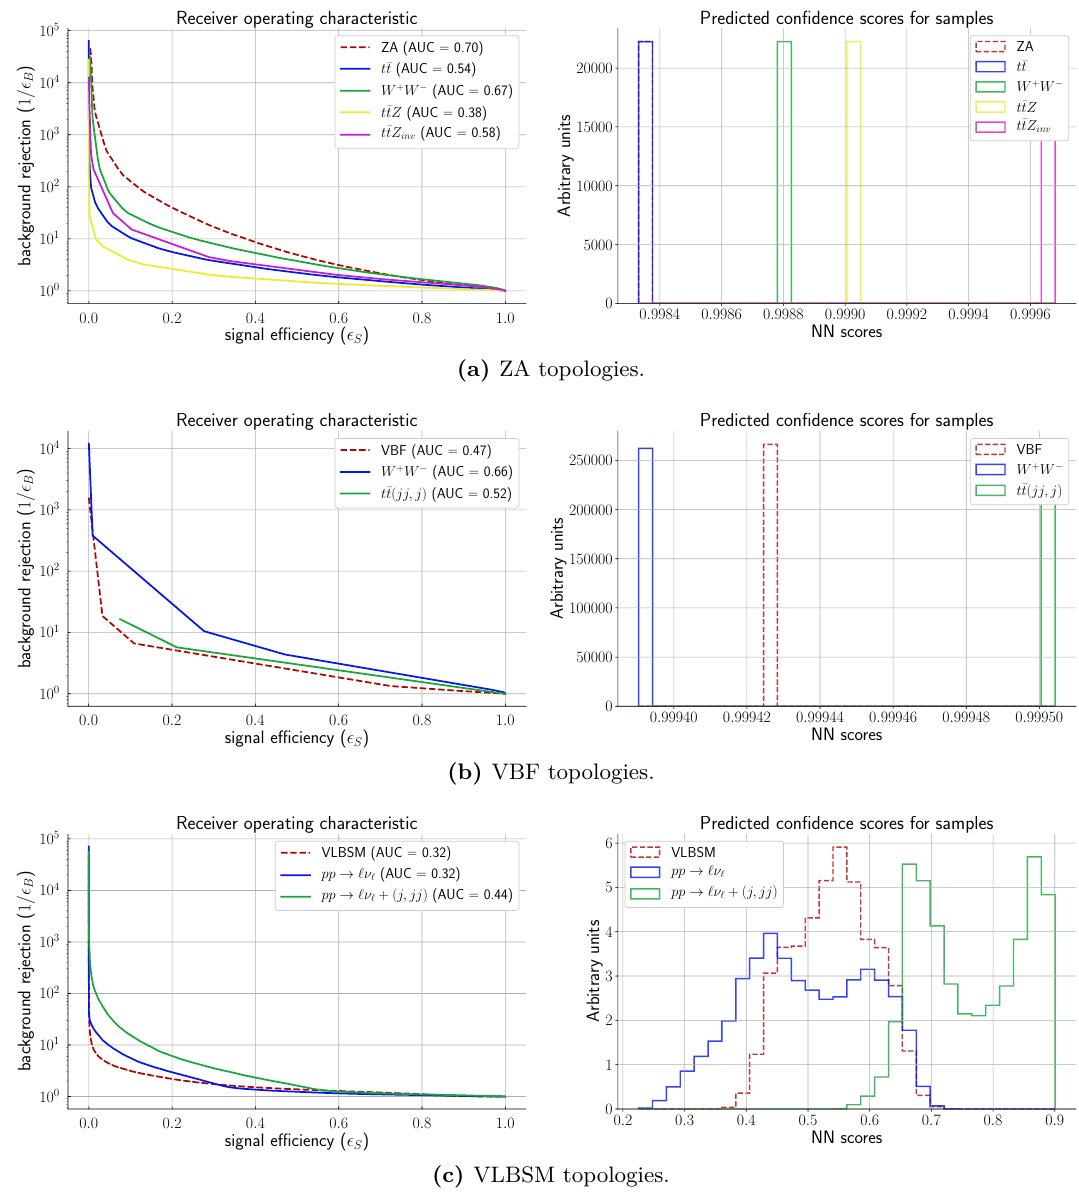
Figure 9. The same as in figure 8 but now computed for an evolutive algorithm that maximizes the Asimov